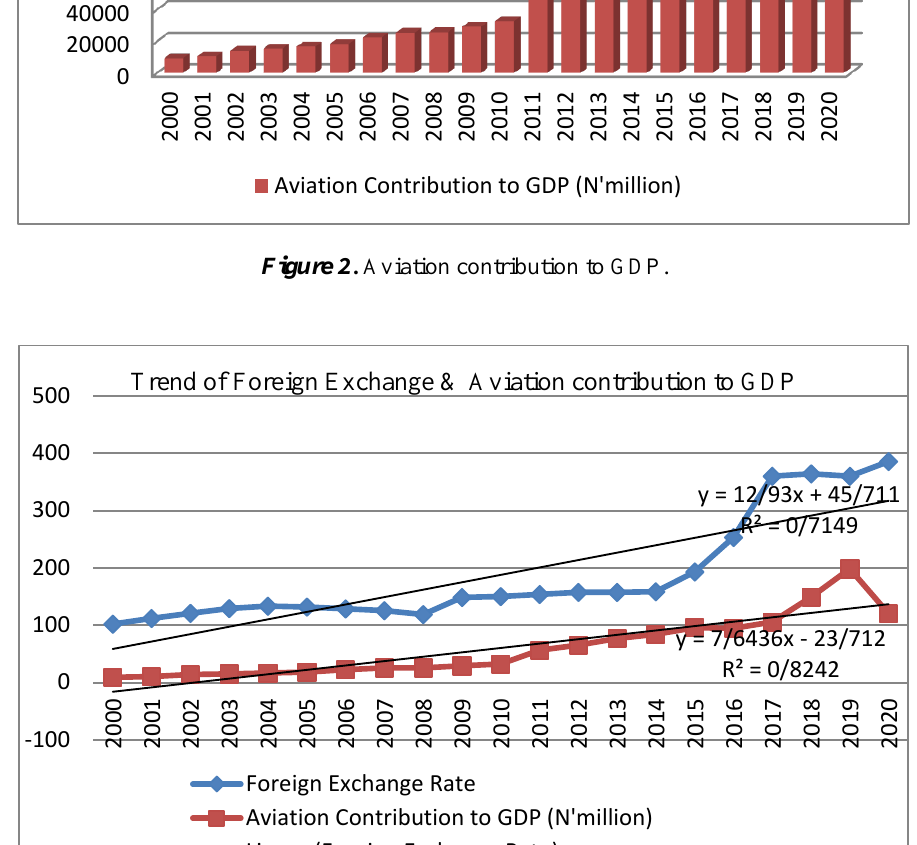
Figure 3 . Trend of exchange and aviation contribution to